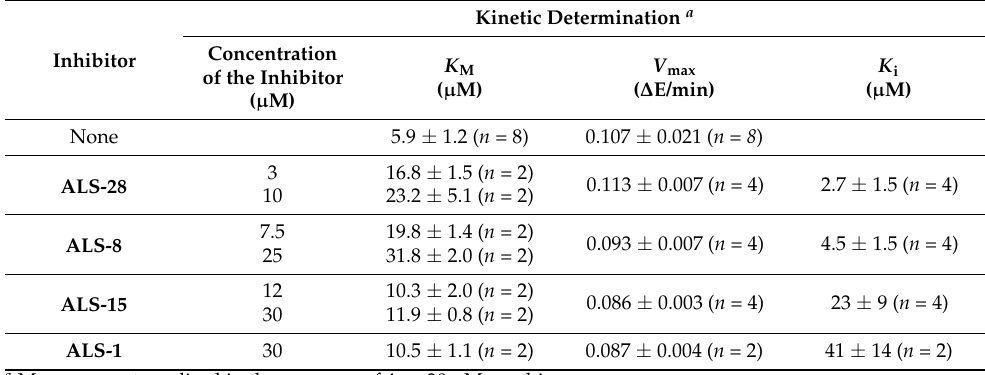
Measurements realised in the presence of 4 → 30 µ M